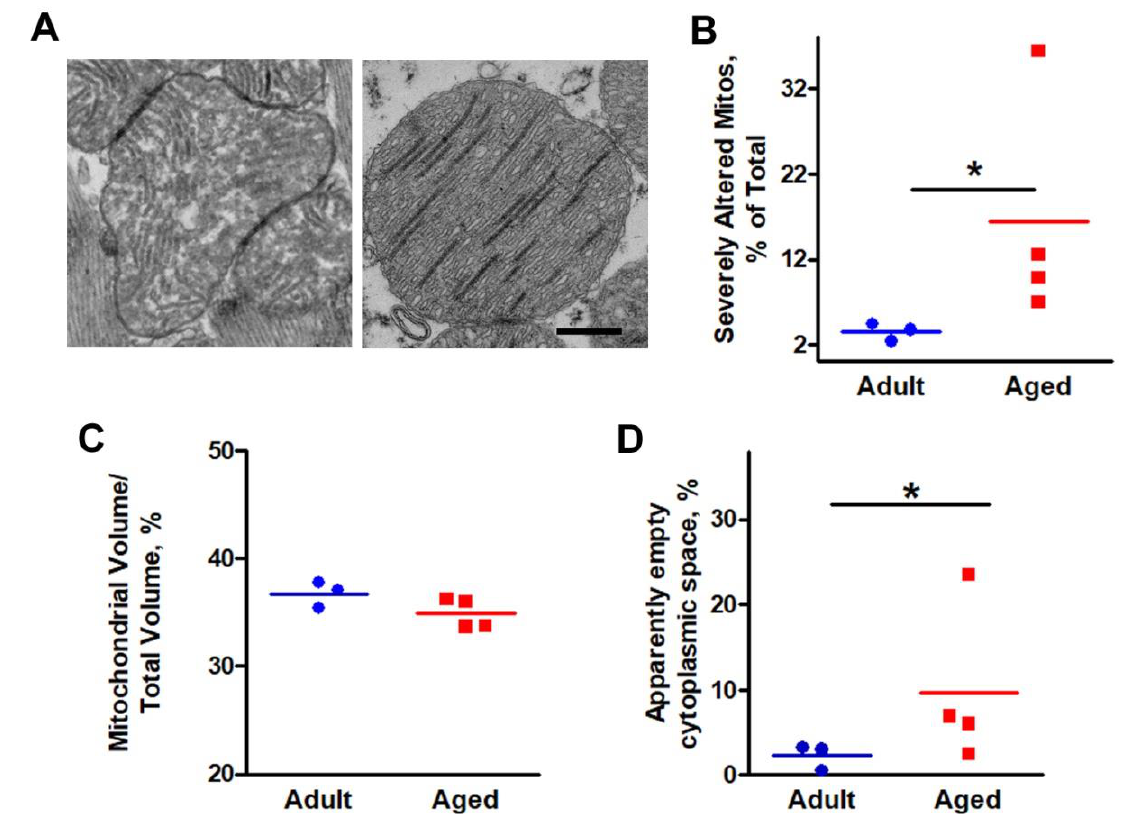
Figure 3. Images and quantitative analysis of mitochondria, and of apparently empty cytoplasmic space. ( A ) Two representative images of severely altered mitochondria. ( B , C ) Percentage of severely altered mitochondria and relative fiber volume occupied by mitochondria. ( D ) Percentage of apparently empty cytoplasmic space. See also Supplementary Table S1. ( B – D ) Scatter dot plots of individual data for each group are horizontally lined with the mean value (* p < 0.01, Chi-square significance test). n = 3 Adult mice, 4 Aged mice). Scale bar: 0.5 μm.